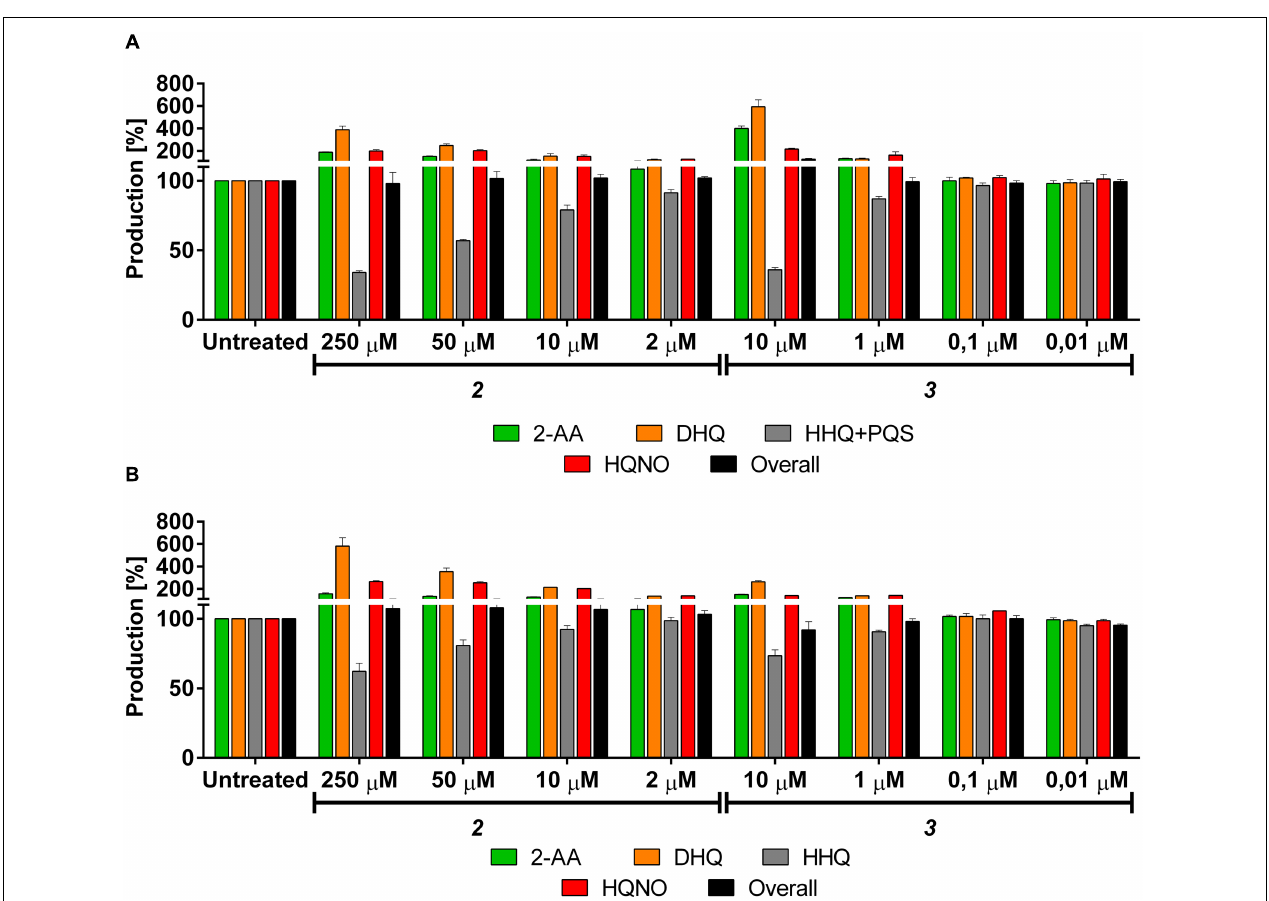
FIGURE 7 | Effects of PqsBC inhibitors on pqs related signal molecules production in PA14 strains. (A) 2 and 3 in PA14 wt . 2-AA: green. DHQ: orange. PQS + HHQ: gray. HQNO: red. Sum of all anthranilic acid derivatives: black. (B) 2 and 3 in PA14 pqsH mutant. 2-AA: green. DHQ: orange. HHQ: gray. HQNO: red. Sum of all anthranilic acid derivatives: black. The error bars indicate Standard Error of the Mean. Statistical analysis performed with one-way ANOVA ( α = 0.05).